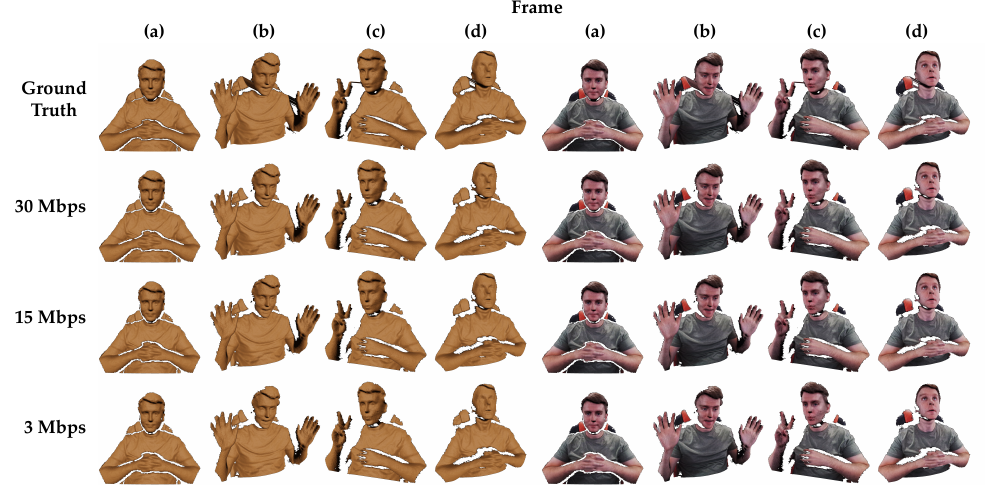
Figure 5. Example frames rendered with Unity’s HDRP for the ground truth data and various encoding qualities taken from several different camera views. The columns on the left half are untextured and the columns on the right are textured with color. All renderings use a lit shader and a single directional light source. The color and depth map resolutions are both 1280 × 720 in all renderings. The first row shows the ground truth data with no postprocessing. The bottom three rows show reconstruction results from videos compressed at different target bitrates with H.264 and 4:2:0 chroma subsampling. The videos contained composite frames with both color texture and MWD-encoded depth information, using n stairs = 6 and a depth range of 800 mm. Full videos of the reconstructed renderings shown in this figure are available as supplementary videos (Supplementary Video S1 and Supplementary Video